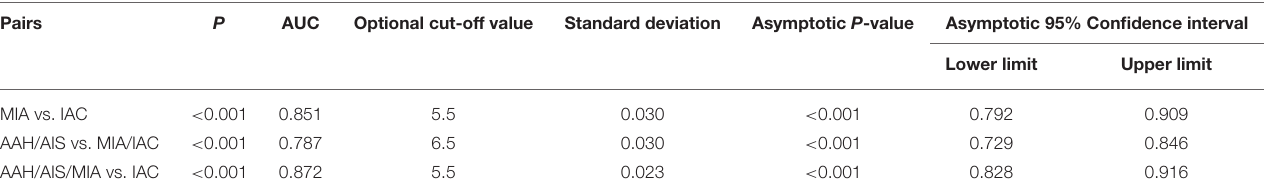
TABLE 3 | Area under the ROC curve (AUC) of the Ki-67 expression level among different pathological subtypes paired groups. Pairs